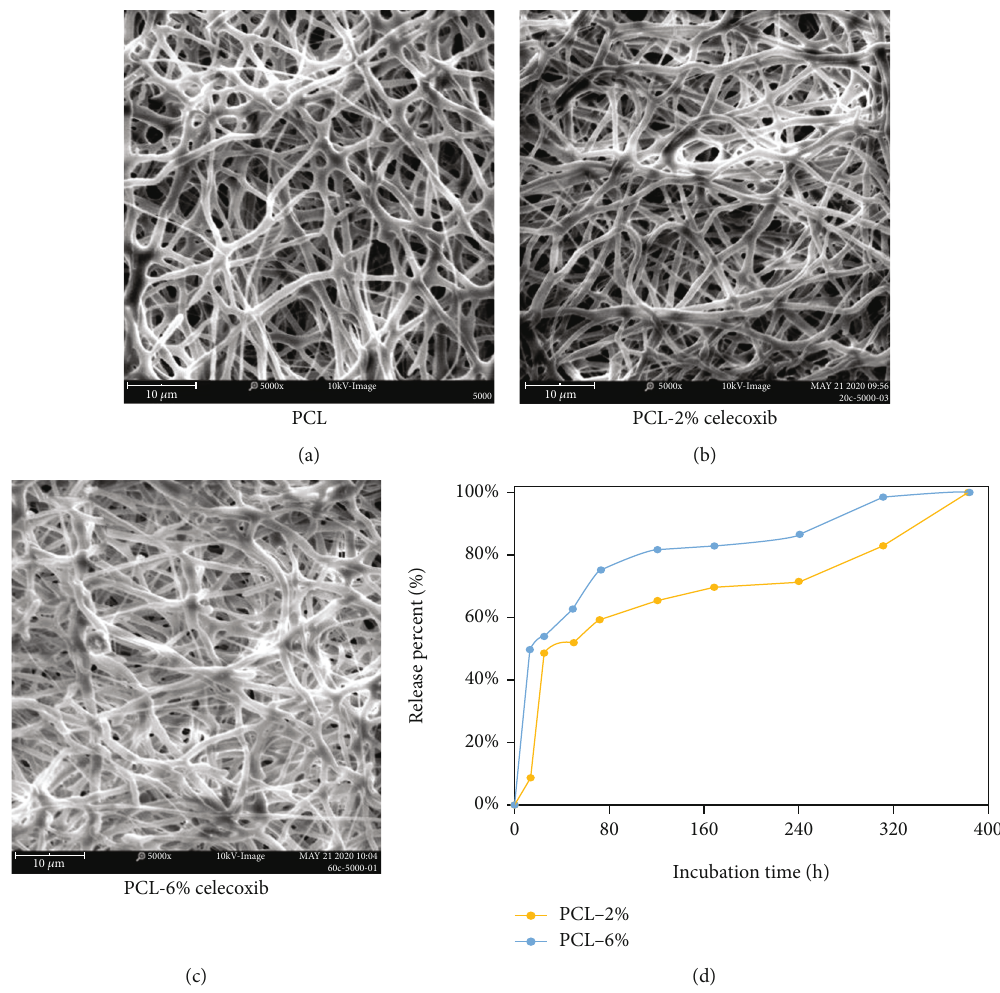
Figure 1: SEM observation of PCL fi brous membranes (a), PCL-2%-CEL fi brous membrane (b), and PCL-6%-CEL fi brous membrane (c). The cumulative release pro fi les of CEL-loaded PCL fi brous membranes